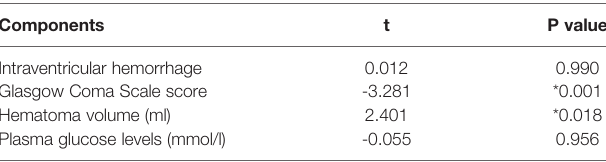
TABLE 3 | Multivariate linear regression analysis between elevated plasma C1q levels and other variables. Components